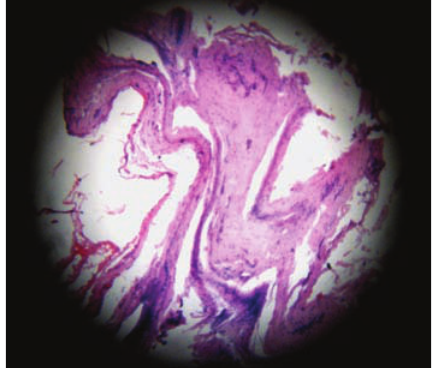
Figure 5: H&E histological section showing fibrofatty tissue and fragmentsofmusclewithseveralthickwalledandthinwalledvessels and areas of hemorrhage with congestion.